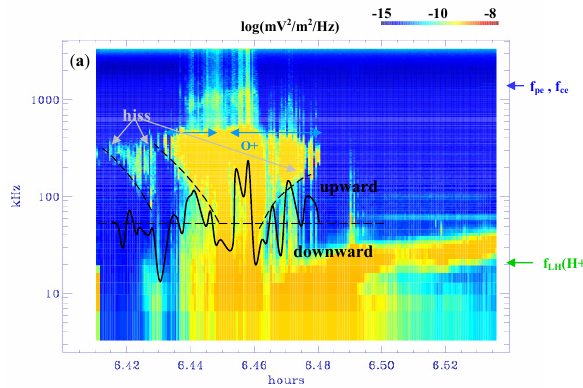
Fig. 8. HF electric field variations in (30kHz, 3.3MHz) frequency range during the same period as in Figs. 5, 6. Funnel-shaped fre- quency time structures associated with hiss emissions are indicated by dashed lines. Solid line stands for the field-aligned current den- sity; positive for the upward and negative for downward current di- rection. Regions of O + outflow are indicated by horizontal